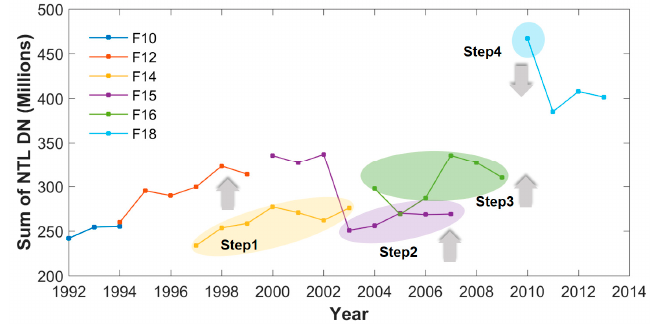
Figure 1. The proposed stepwise calibration of DMSP/OLS NTL series. The lines with different color indicate the sum of global NTL digital numbers (DNs) for different satellites (F10, F12, F14, F15, F16, and F18). Shaded ellipses with numbers represent steps of calibration in a sequential order. The arrows indicate modification of NTL series corresponding to each ellipse.